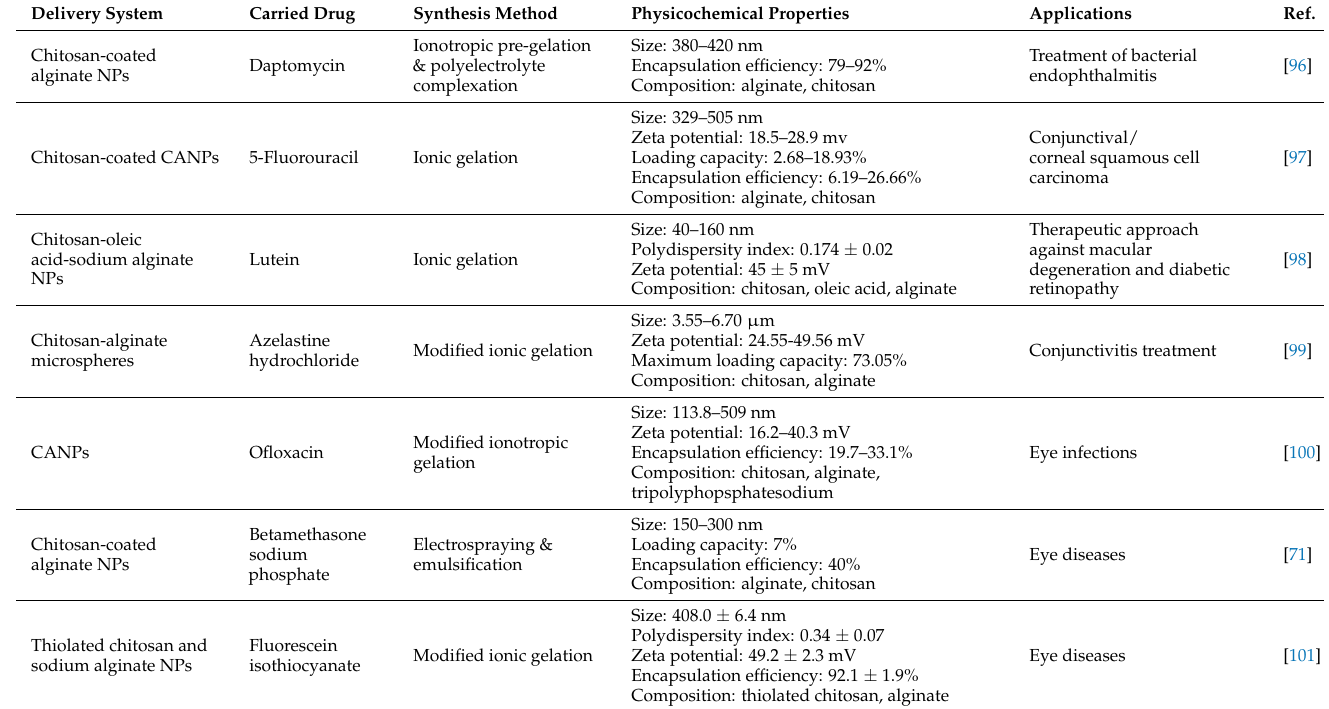
Table 2. Examples of ocular drug delivery systems based on chitosan-alginate